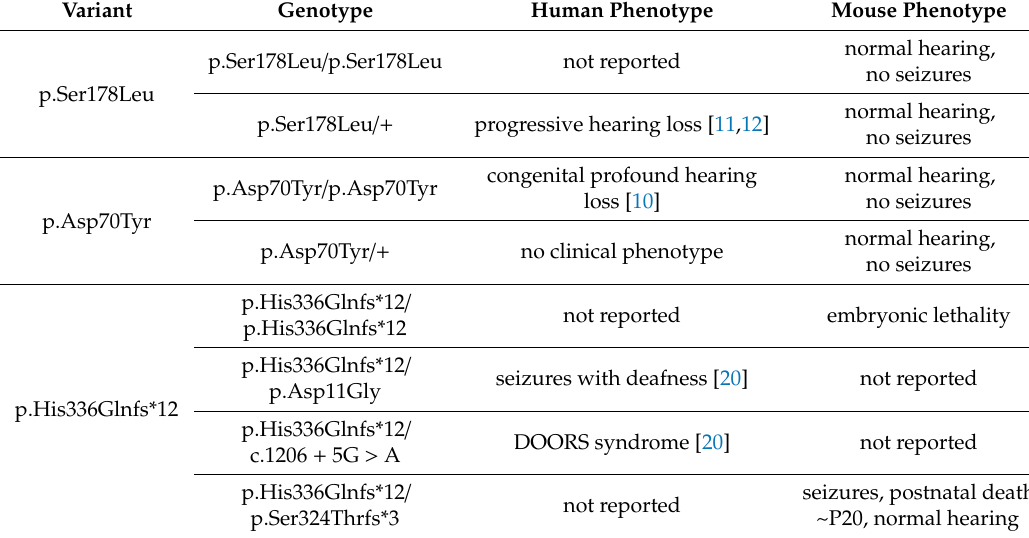
Table 1. TBC1D24 variants and associated